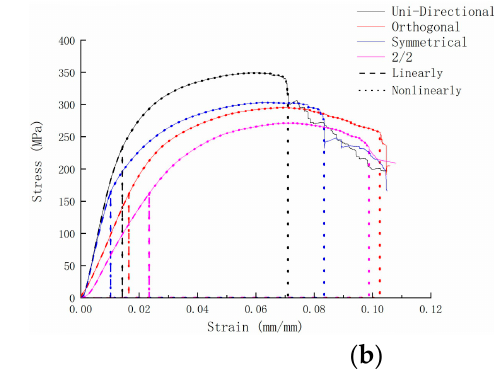
Figure 10. The bending stress-strain curve of 3DDAI Kevlar/EP armor materials with different laying methods. ( a ) The warp direction. ( b ) The weft direction.